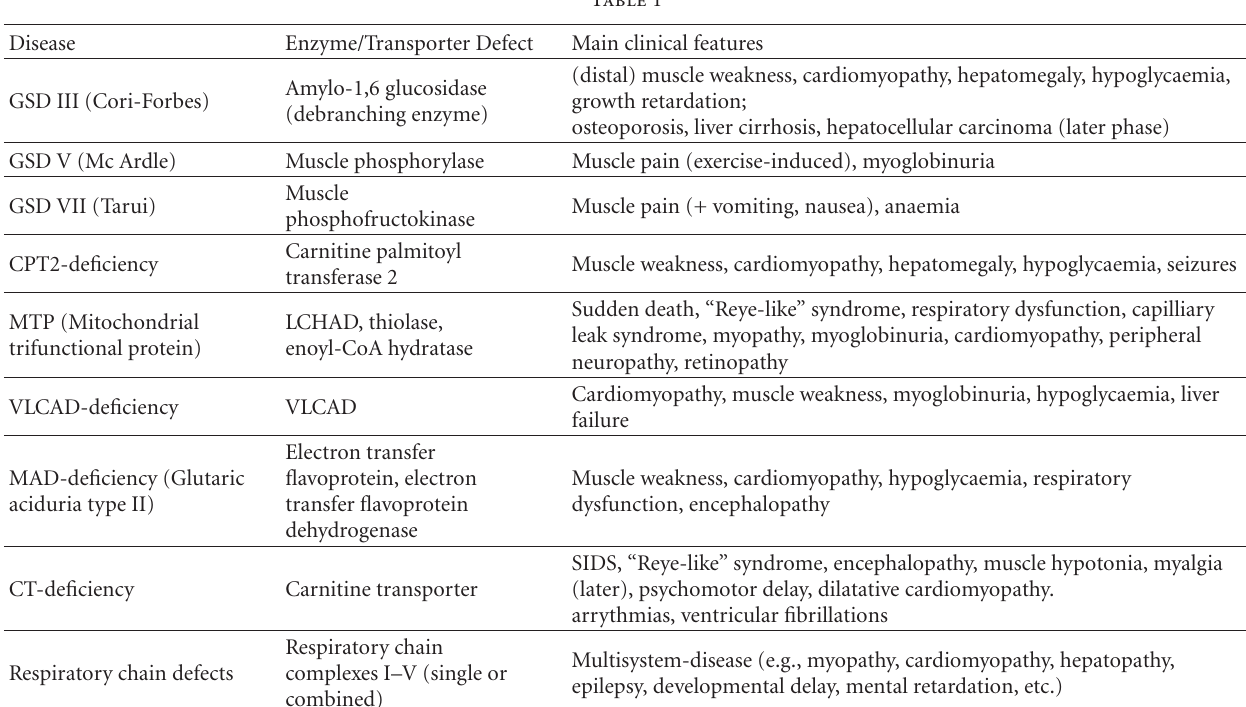
Disease Main clinical